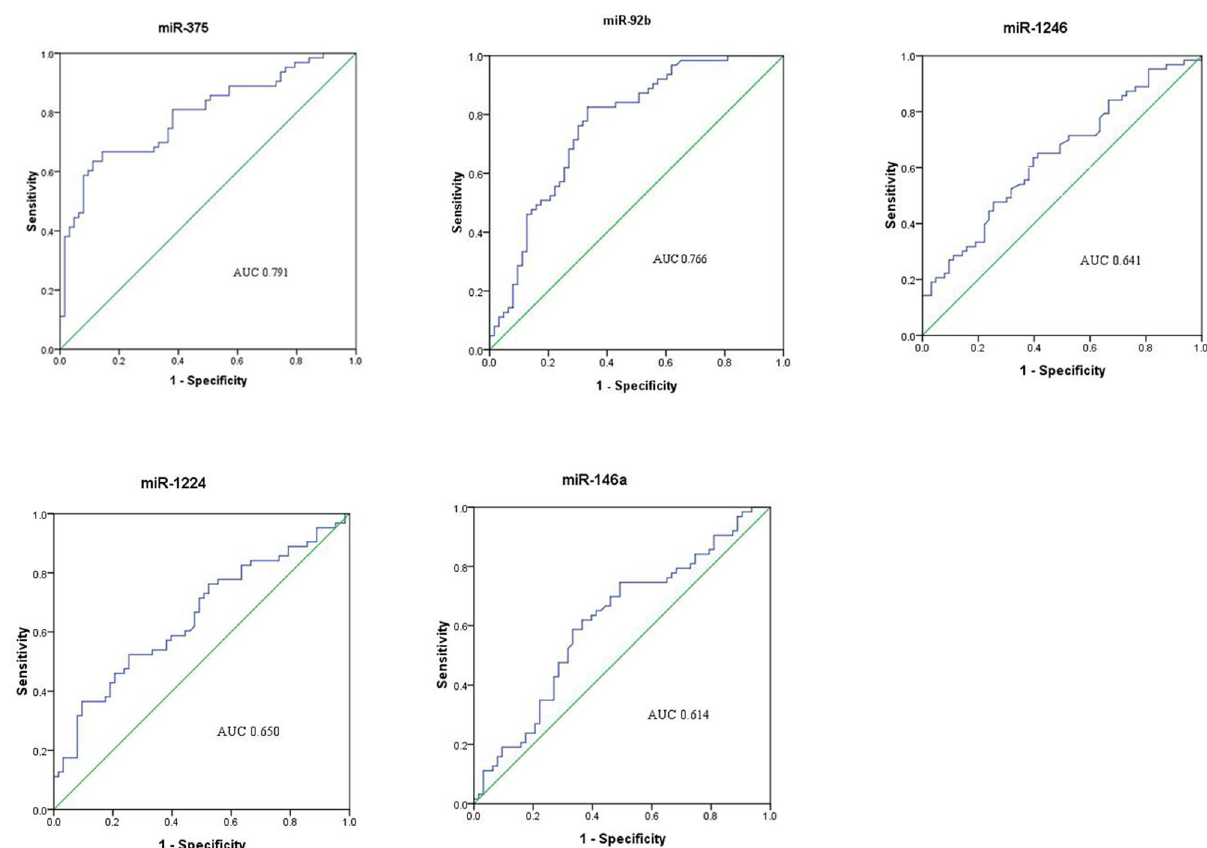
Figure 2. ROC analysis of plasma miRNAs for monitoring chemotherapy resistance in SCLC. AUC estimation for miRNAs in discriminating between pre- and post-chemoresistant patients in the set of 38 SCLC